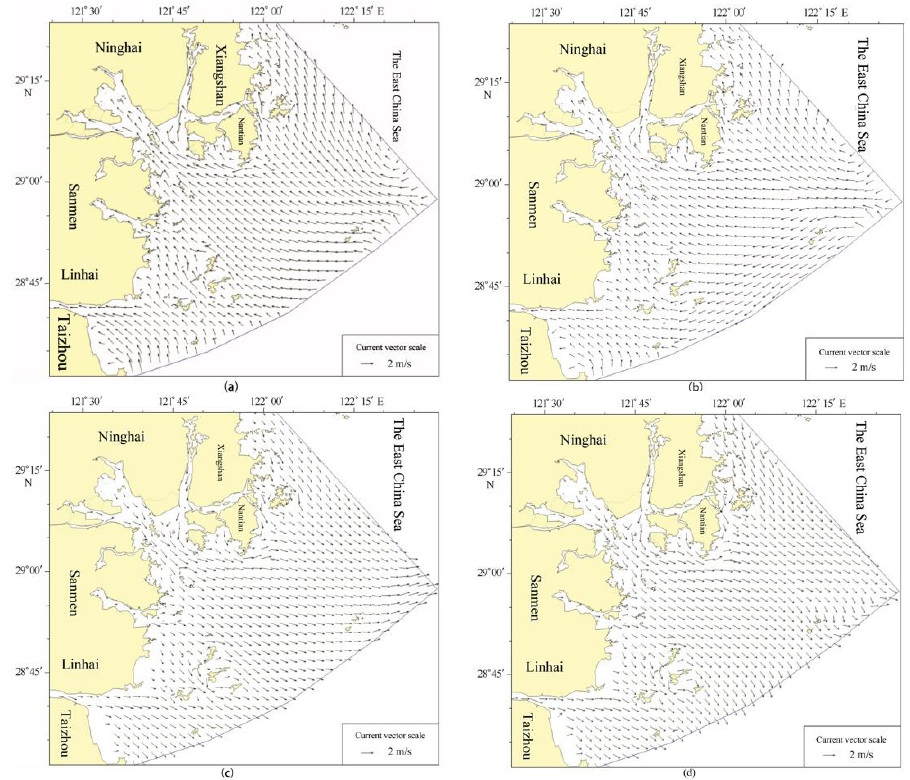
Figure 5. Depth-average velocity vectors during flood and neap (the entire domain). (( a , b ) flood spring and flood ebb, ( c , d ) neap spring and neap ebb).